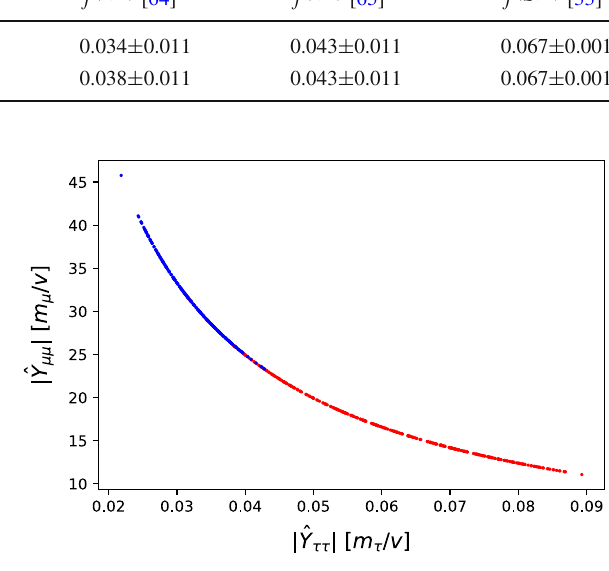
Fig. 6 The flavor diagonal couplings ˆ Y (cid:8)(cid:8) in the unit of m (cid:8) /v . The red (blue) points corresponds to θ 23 lies in the first (second)